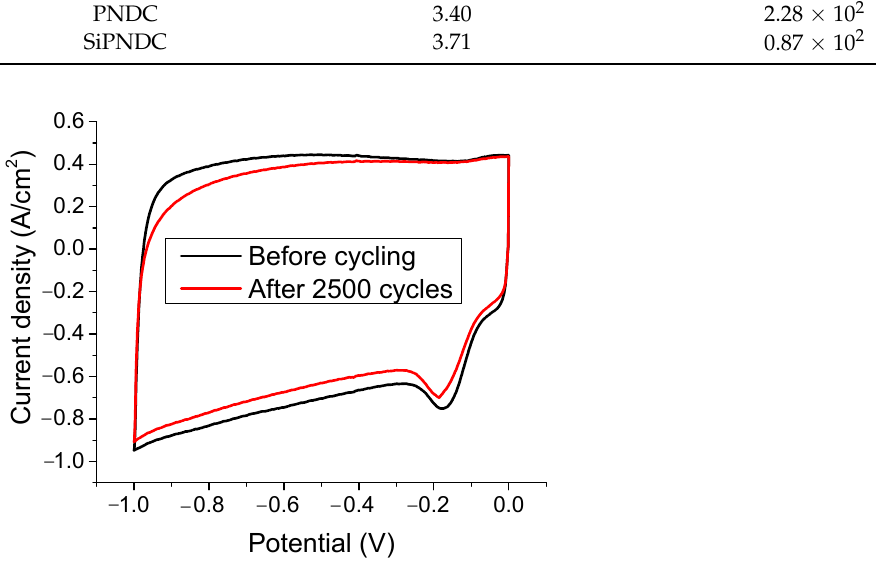
Figure 9. Cyclic voltammograms of SiPNDC in O 2 saturated 0.1 M KOH at 100 mV/s over 2500 con-